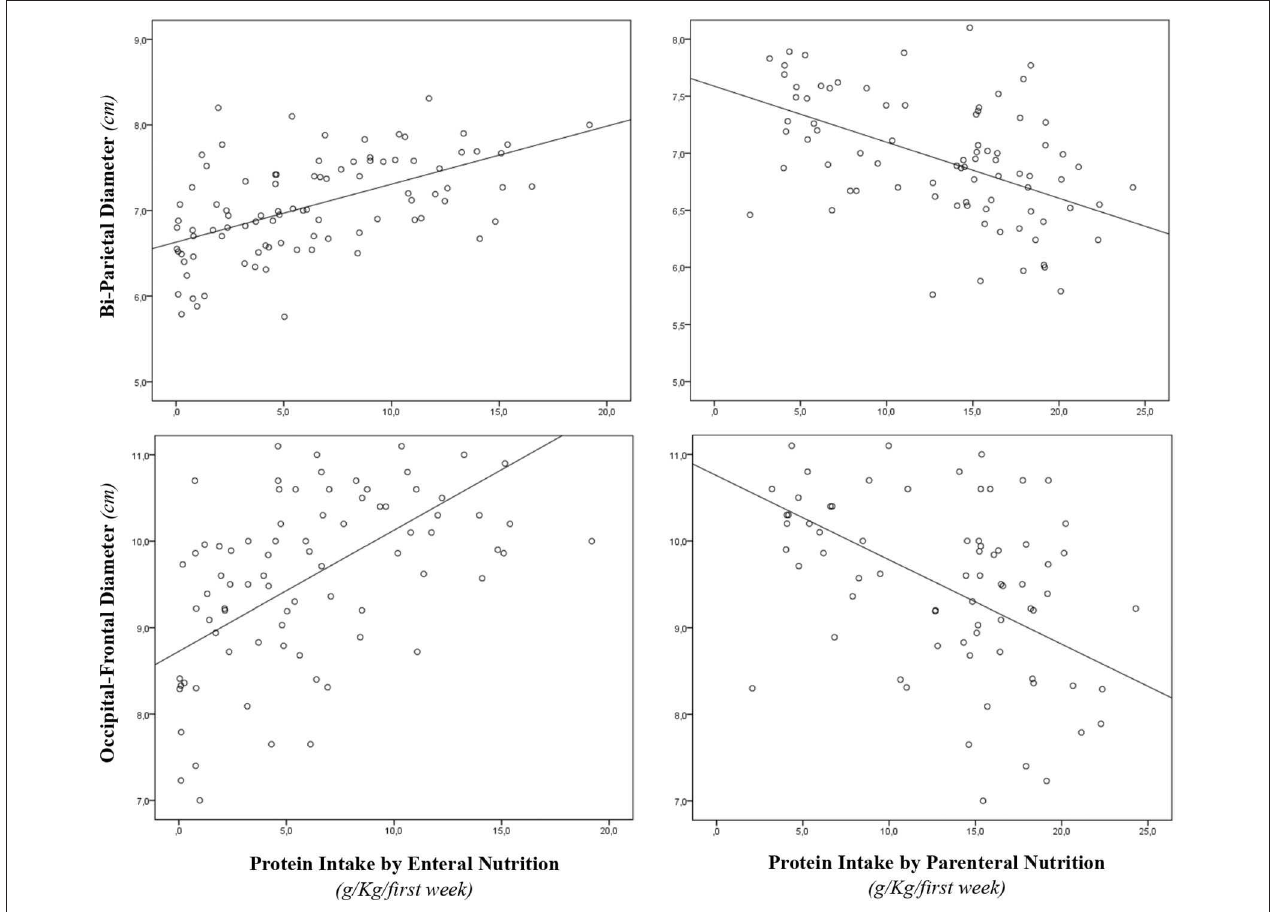
FIGURE 2 | Correlation between brain measures at 28 days of life and early protein intake. Enternal nutrition: Bi-Parietal Diameter ( r = 0.490, p < 0.001), Occipital-frontal diameter ( r = 0.608, p < 0.001). Parameter nutrition: Bi-parietal diameter ( r = − 0.524, p < 0.001), Occipital-frontal diameter ( r = − 0.568, p < 0.001).